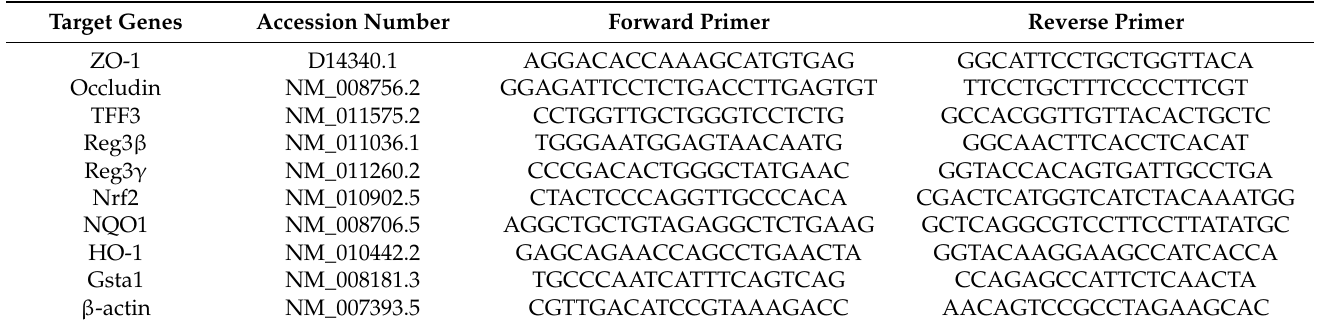
Table 1. Primer sequences used in Real-time